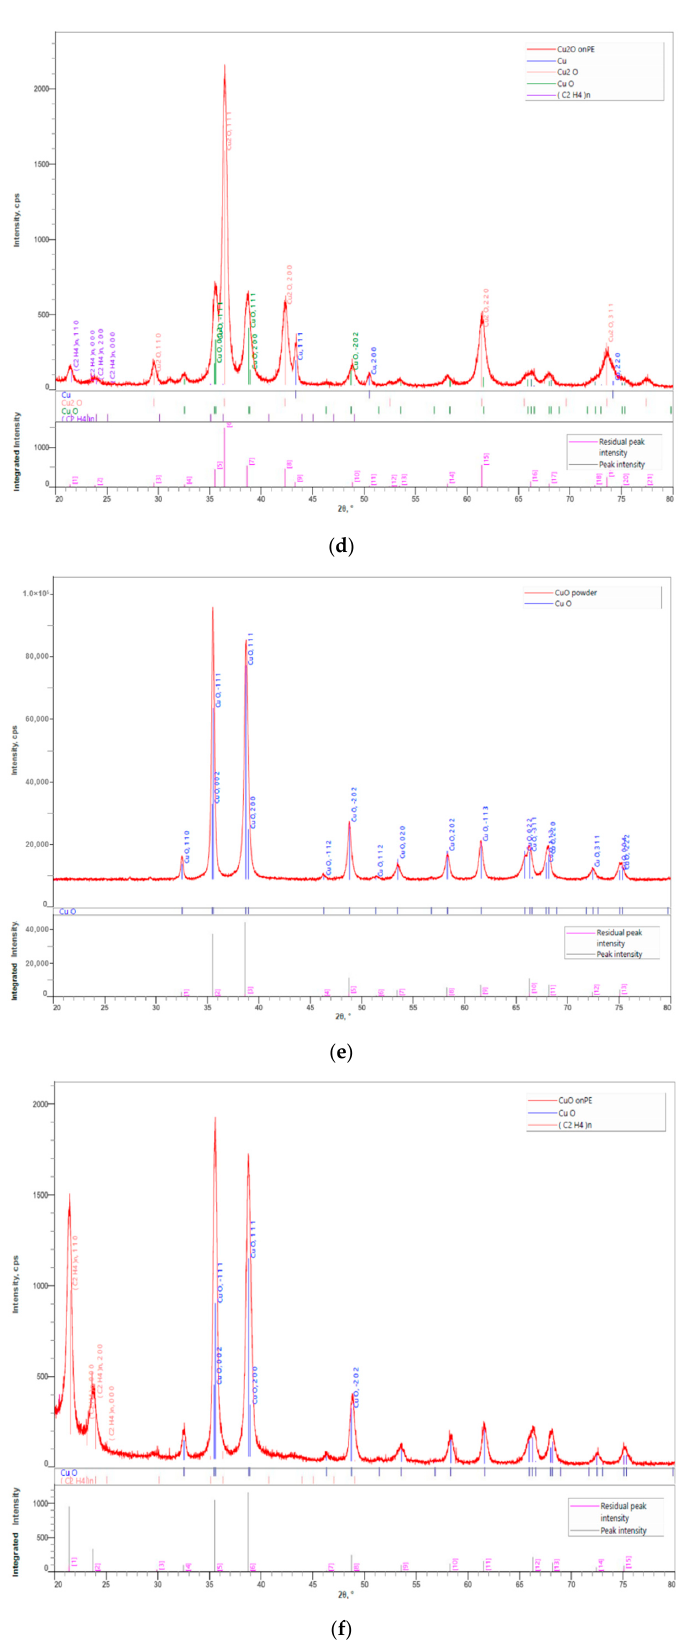
Figure 3. X-ray Di ff raction (XRD) analysis of ( a ) CuNPs; ( b ) LLDPE / CuNPs; ( c ) Cu 2 ONPs; ( d ) LLDPE / Cu 2 ONPs; ( e ) CuONPs; ( f ) LLDPE /